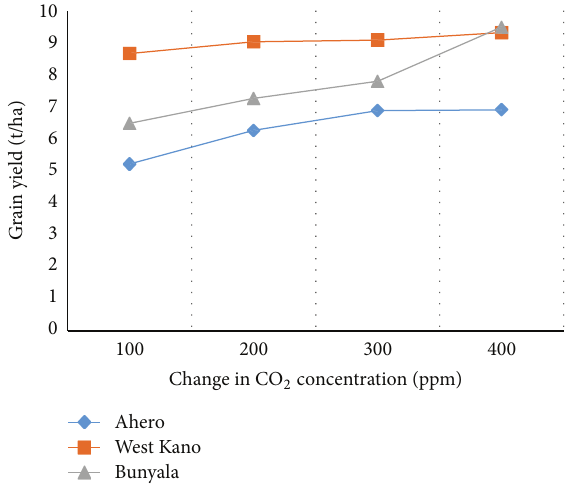
Figure 8: Effects of increase in CO 2 concentration on IR 2793-80-1 grain yield in Ahero and West Kano irrigation schemes, Kenya.